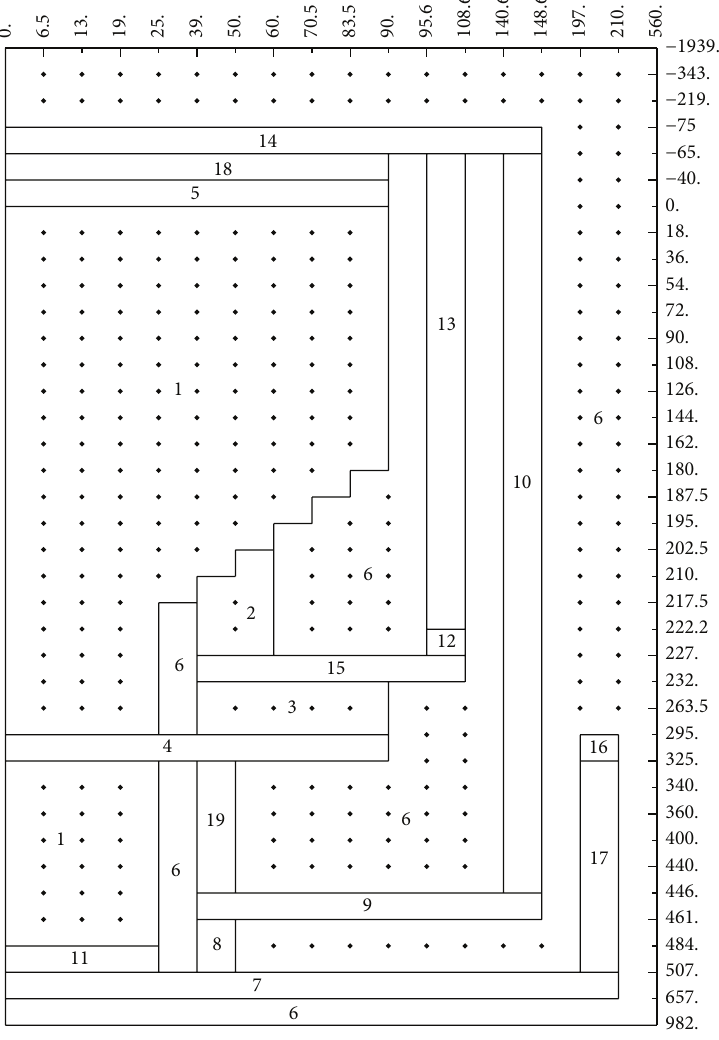
Figure 5: Gas convection model of the HTR-10. (1) Reactor core; (2, 3) flow channel in the bottom reflector; (4) hot helium plenum; (5) top cavity of the core; (6) non-flow region; (7) bottom cavity of the RPV; (8, 9) bottom coolant channels; (10) flow channel in the side reflector; (11, 12) throttle plate; (13) control rod channel; (14) cold helium plenum; (15) small plenum in the bottom reflector; (16) inlet cavity of the RPV; (17) annular space of the RPV; (18) flow channel in the top reflector; (19) leak flow